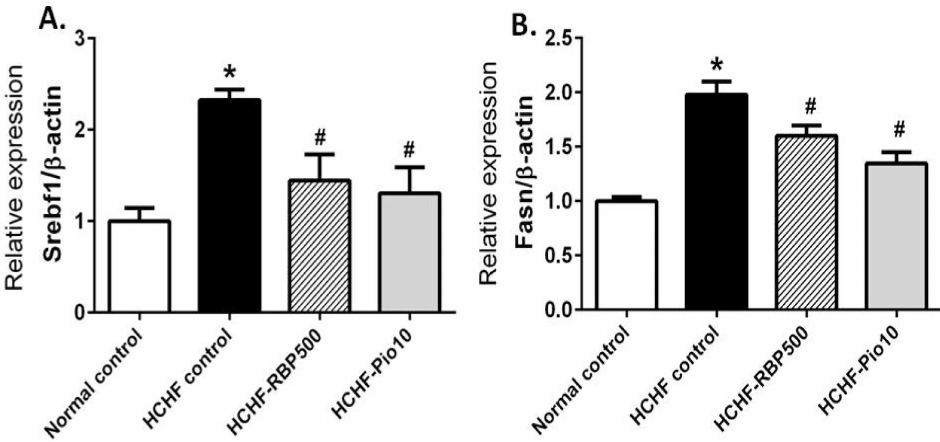
Figure 5. Effects of RBP on expression of lipogenic genes Srebf1 ( A ) and Fasn ( B ) in HCHF-fed rats. Oral administration of RBP 500 mg/kg or pioglitazone 10 mg/kg daily